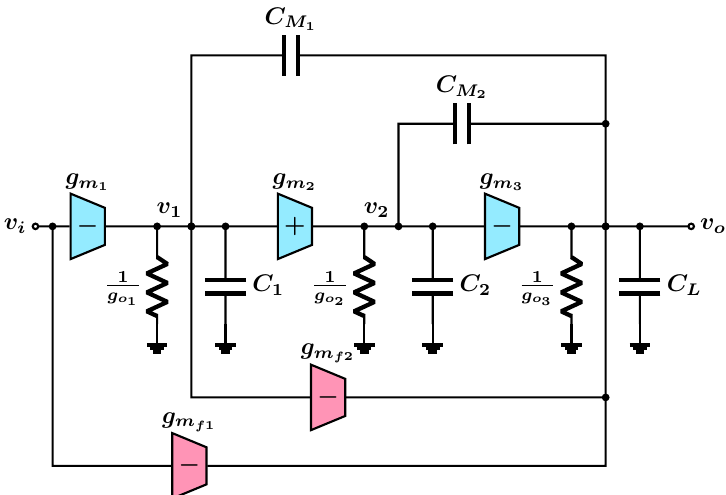
Figure 1. Small-signal model of an example three-stage